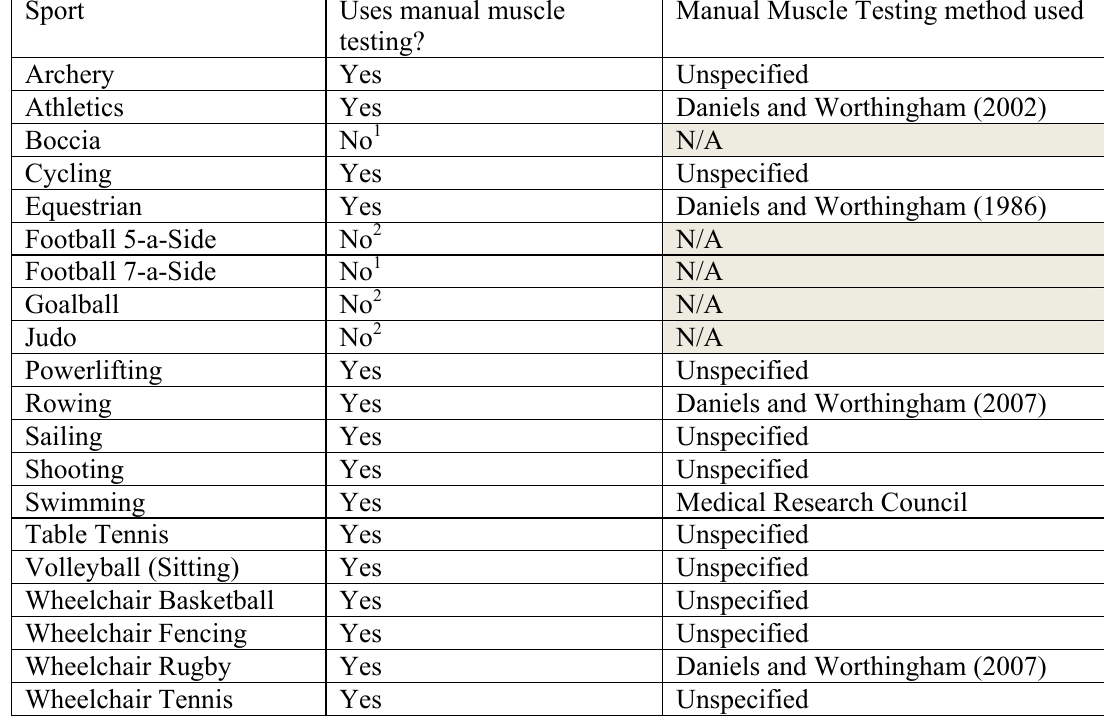
Table 1 : Summer Paralympic sports which explicitly incorporate the use of manual muscle testing in the classification process (i.e., to determine eligibility or assign class).